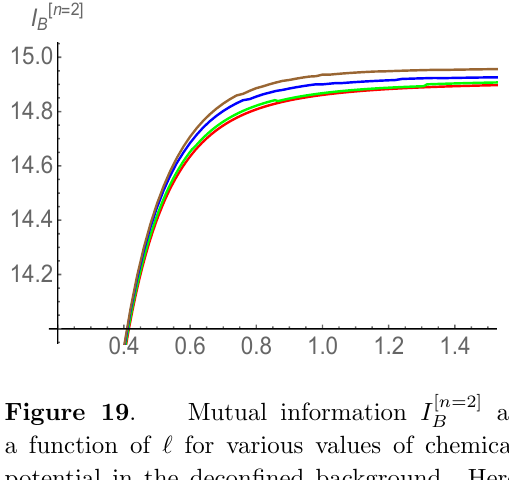
Figure 18 . Mutual information I [ n =2] function of ‘ for various values of temperature in the decon(cid:12)ned background. Here (cid:22) = 0 and x = 0 : 1 are (cid:12)xed and red, green and blue curves correspond to T=T c = 1 : 2, 1 : 6 and 2 : 0 respec- tively. In units GeV.